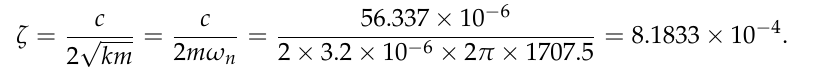
Figure 5. Block diagram of the electrostatic active damping control system for the micromachined silicon resonant accelerometer.